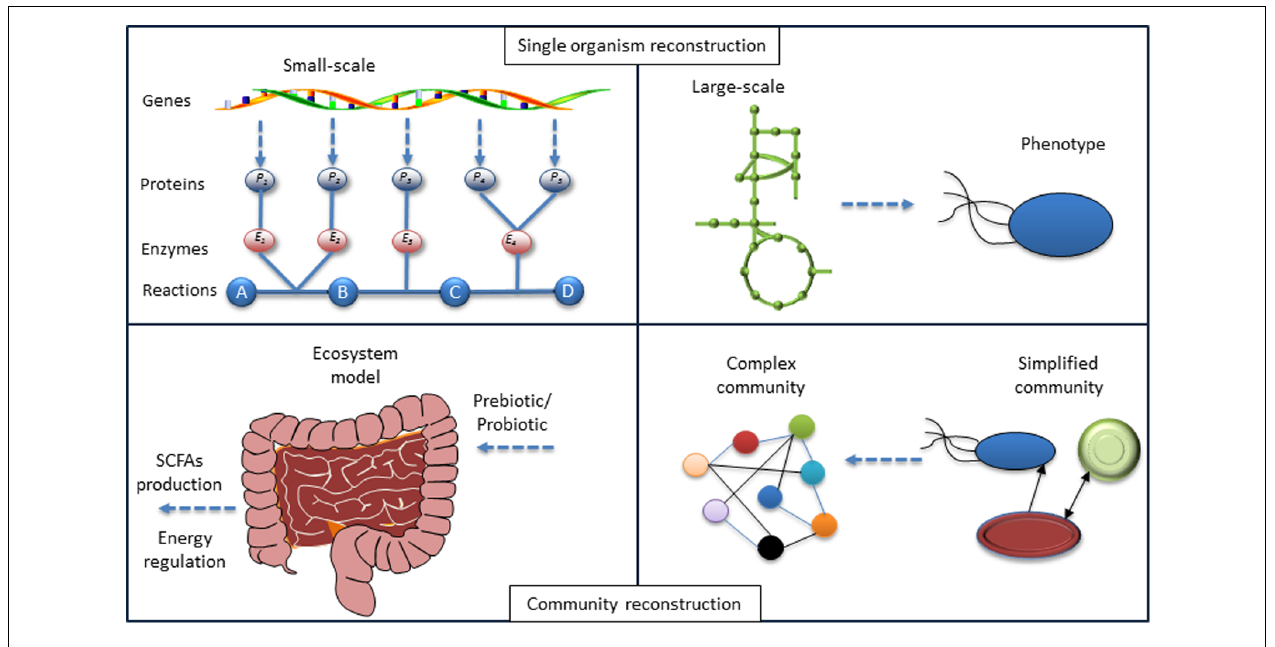
FIGURE 1 | Lessons from systems biology of single organisms to a community. The model reconstruction for single organism based on genotype–phenotype connections has been developed. Identifying the local interactions between organisms in a community and the application of